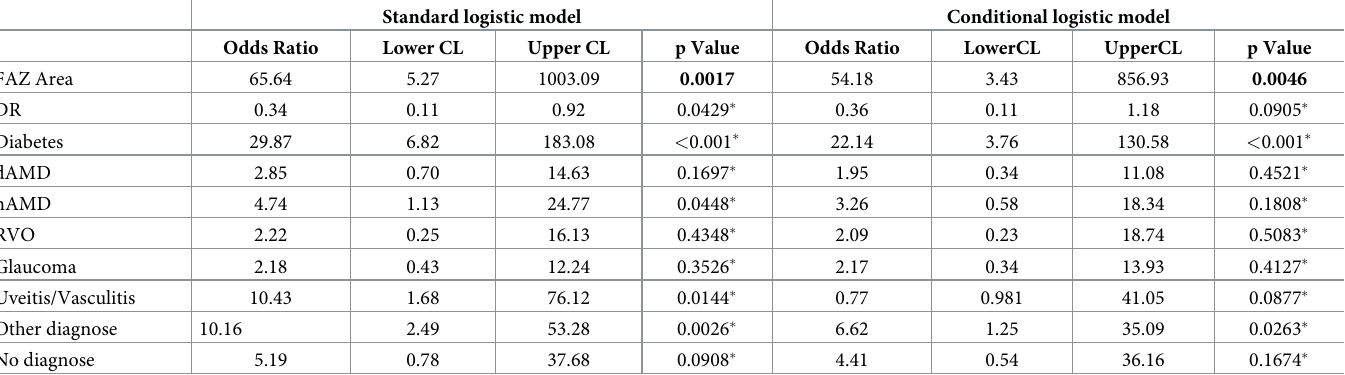
FAZ = Foveal avascular zone; DR = Diabetic Retinopathy as graded by Retinal Specialist on fluorescein angiography, dAMD = Dry age-related macular degeneration, nAMD = neovascular age-related macular degeneration, RVO = Retinal vein occlusion. � p values only for descriptive use, multiple testing corrections were not